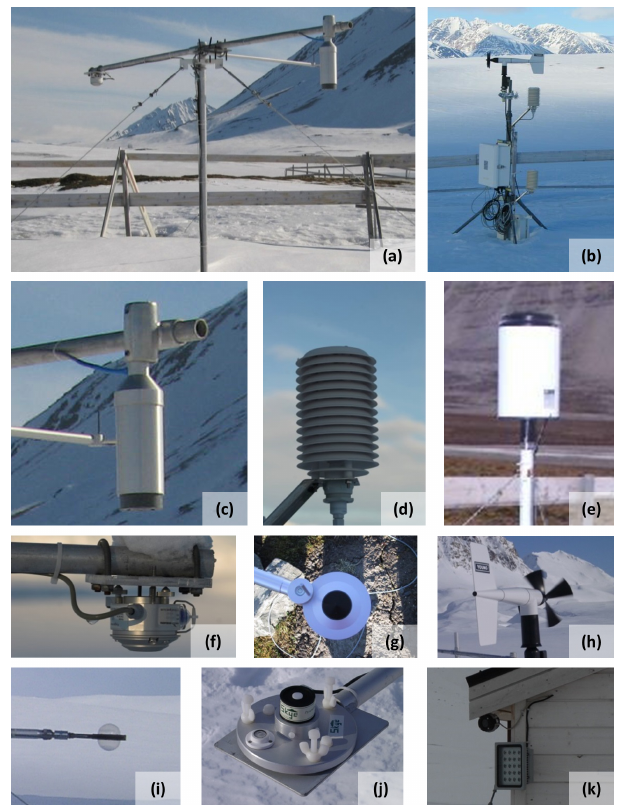
Figure C2. Climate station, Bayelva, September 1998– August 2009. (a) Radiation–snow tower, (b) meteorological tower, (c) snow height sensor (from September 1999: 2m; from July 2001: 1.6m; from September 2003: 1.45m), (d) temperature– relative humidity (2m) and temperature (1m) sensor, (e) rain gauge (1.68m top of bucket above ground level), (f) pyrgeometer (from May 2003: 2m; from September 2003: 2m) installed in May 2002, (g) net radiometer (from April 2000: 1.14m; from September 2003: